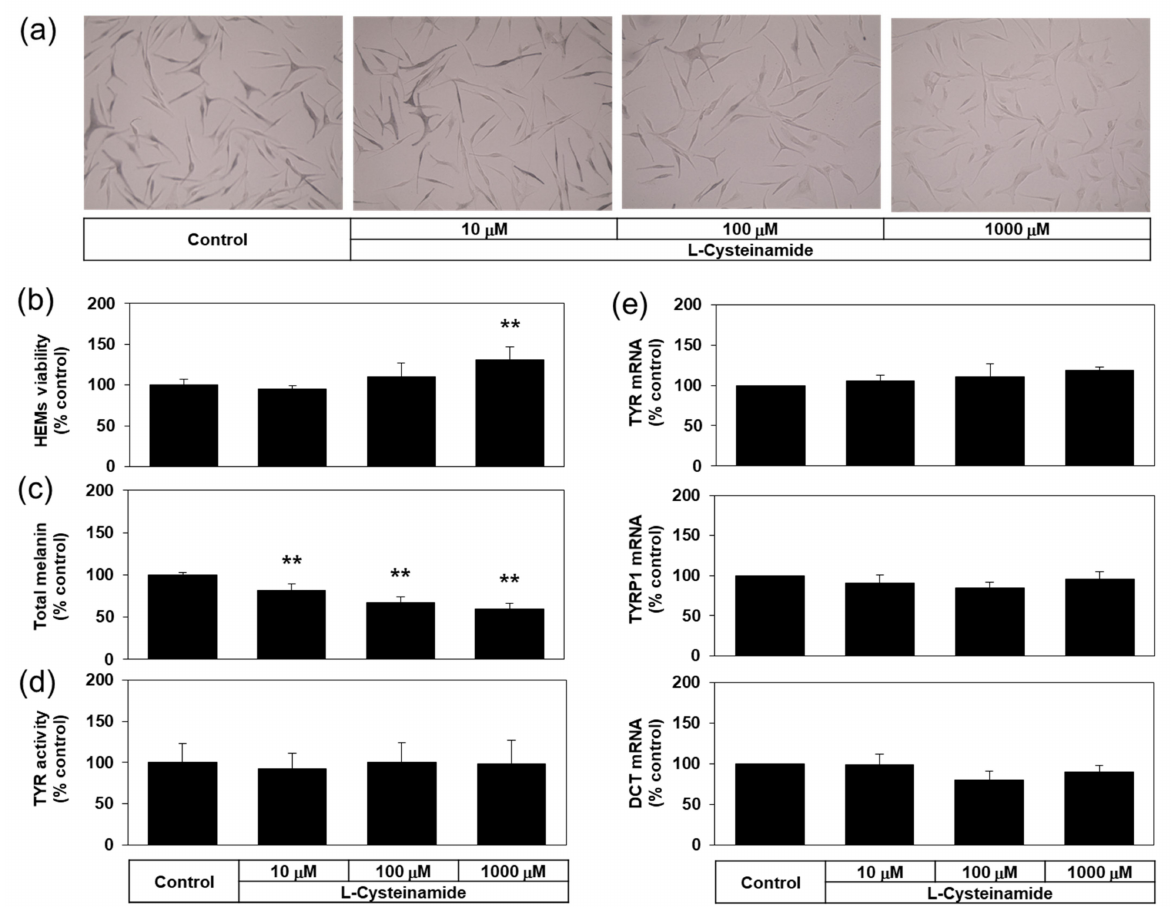
Figure 11. Effects of L-cysteinamide on the viability, the melanin content, the cellular TYR activity, and the mRNA expression levels of melanogenic enzymes in normal human epidermal melanocytes (HEMs). Cells treated with vehicle (control) or L-cysteinamide at the specified concentration for 72 h ( a – c ) or 24 h ( d , e ). Cells were subjected to Fontana-Masson staining ( a ), and assays to determine total melanin content ( n = 4) ( b ) and viability ( n = 4) ( c ). Cellular TYR activity was determined using cell lysates ( n = 4) (d). The mRNA levels of TYR, TYRP1, and DCT were determined by qRT-PCR and normalized to GAPDH mRNA levels ( n = 3) ( e ). Data are presented as % of control (means ± SD). ** p < 0.01 vs.